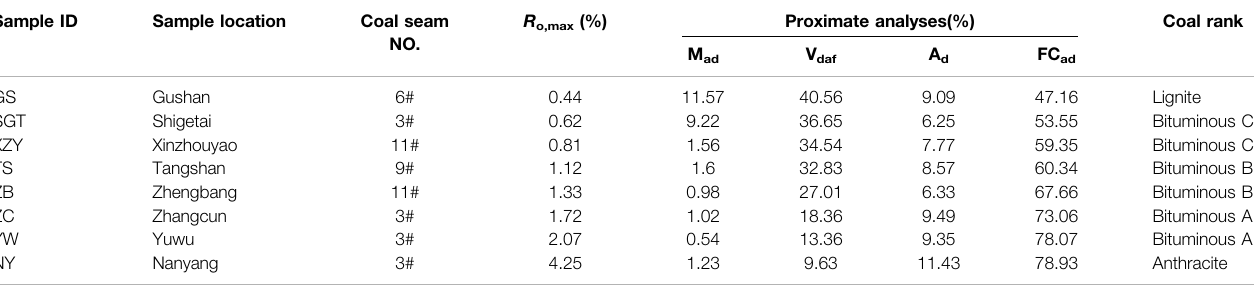
TABLE 1 | The maximum vitrinite re fl ectance, proximate analyses and coal rank of coal samples. Sample ID Sample location